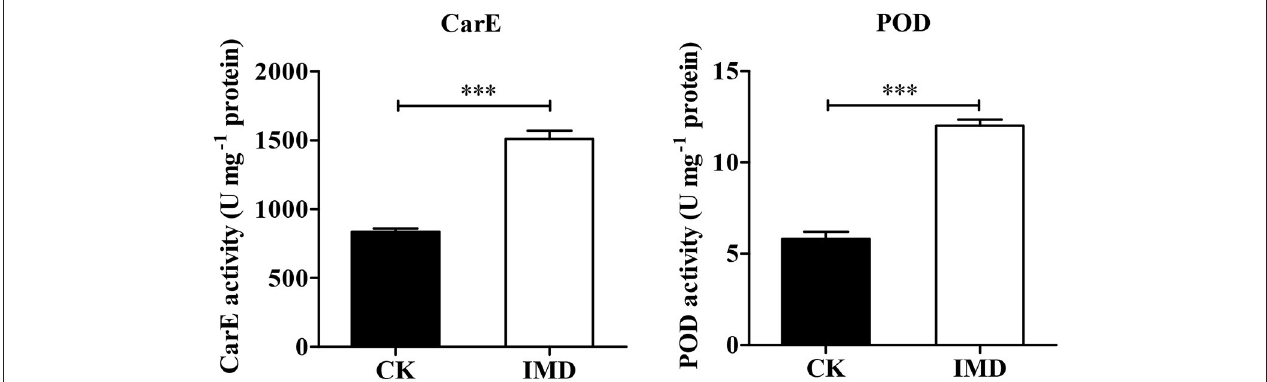
FIGURE 8 | Activities of CarE and POD. Asterisk over the bars designate a significant difference based on student’s t -test: * P < 0.05, ** P < 0.01, *** P < 0.001, and the error bars is ± SE bars. N = 3.